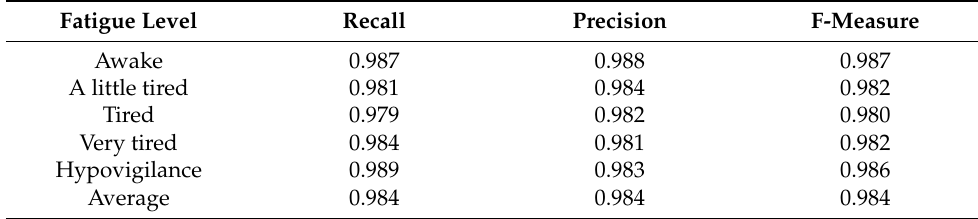
Table 5. Evaluation of the HyMobLSTM model using MiraclHB dataset.